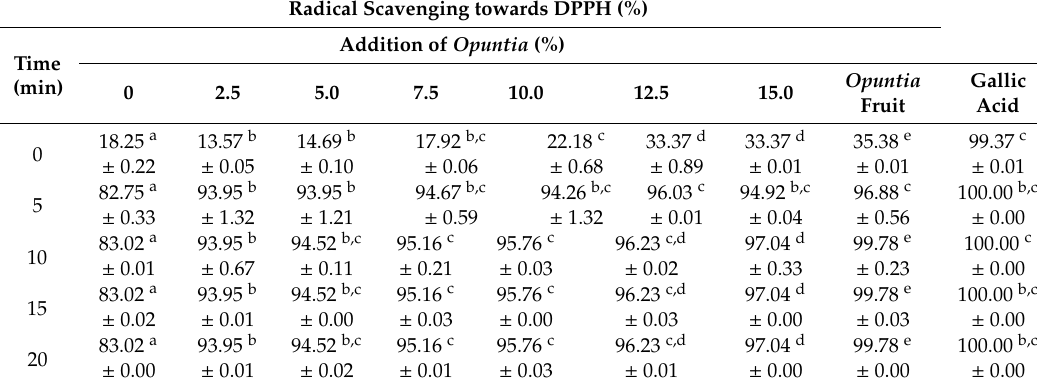
Table 1. Radical scavenging activity of gluten-free pasta samples depend on time and Opuntia fruit addition (n = 3 mean ±